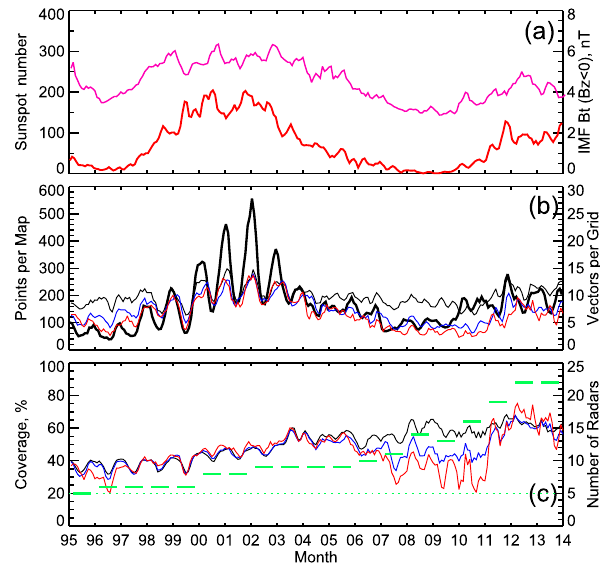
Figure 1. (a) Sunspot number (red) and transverse component of the IMF B − t (pink) computed as the average of monthly histogram distributions for B − t = [ − 12,0]nT. (b) Monthly average number of grid points on the standard 2min SuperDARN map (thick solid line) and monthly average number of vectors for each grid point. (c) Grid point coverage of the month-long data set at magnetic latitudes pole- ward of 50 ◦ and all magnetic local times. Thin black, blue and red lines in (b) and (c) correspond to cases A, B, and C (Table 1), re-